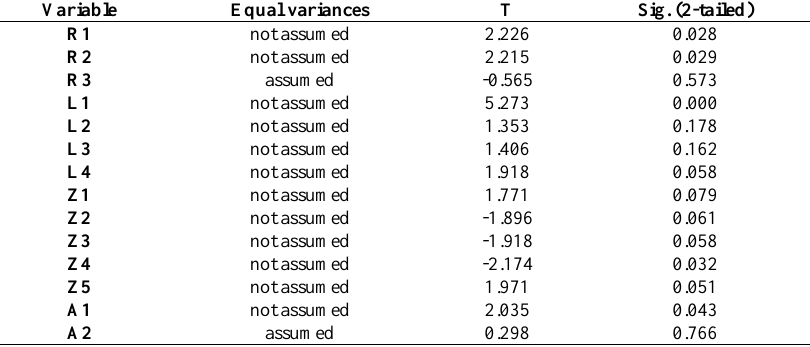
Table 6. Contingency table of prosperous and non-prosperous companies